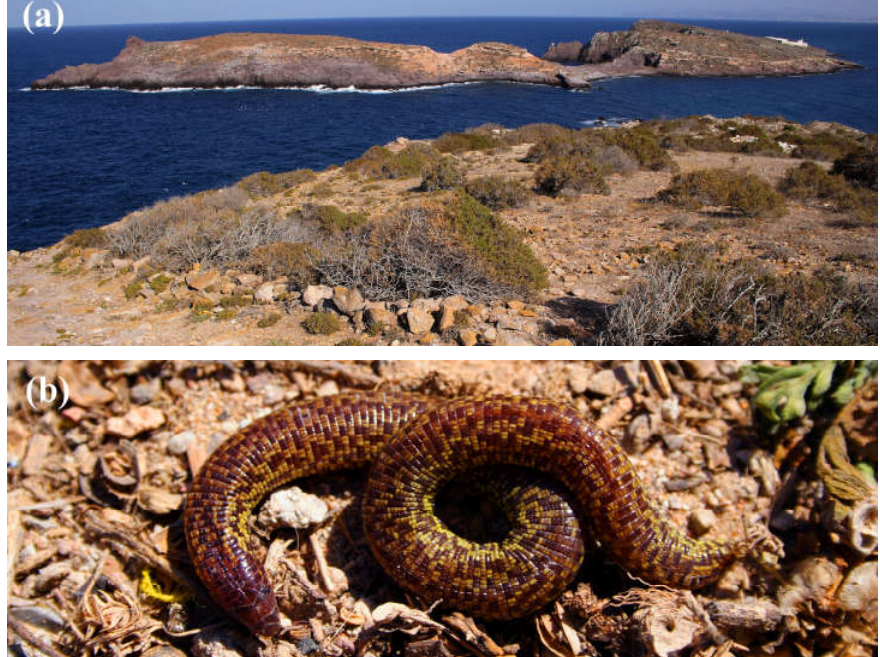
Figure 1. ( a ) Typical habitat of Isabel II Island (Chafarinas Islands) where T wiegmanni amphisbaenians were studied, with Rey Island in the background; ( b ) an adult T wiegmanni amphisbaenian as it was found under a stone.